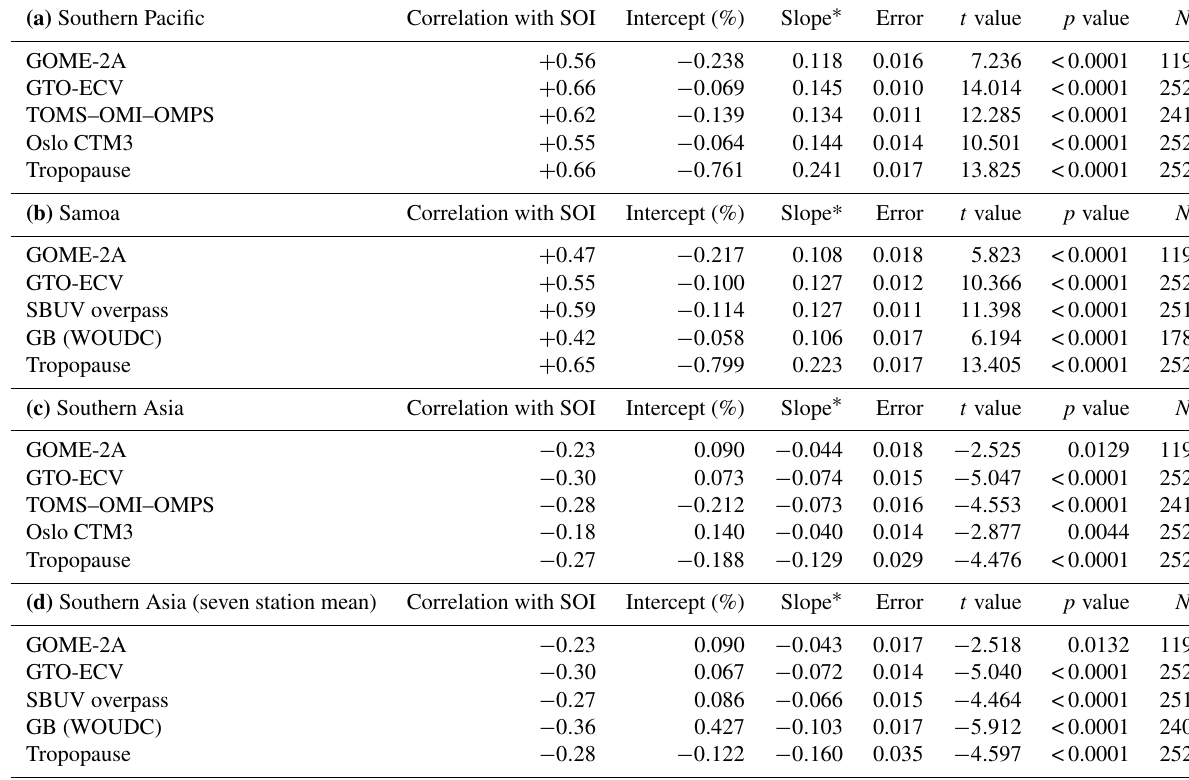
Table 5. Statistics of the comparisons between total ozone, tropopause pressures, and SOI for (a) southern Pacific (10–20 ◦ S, 180–220 ◦